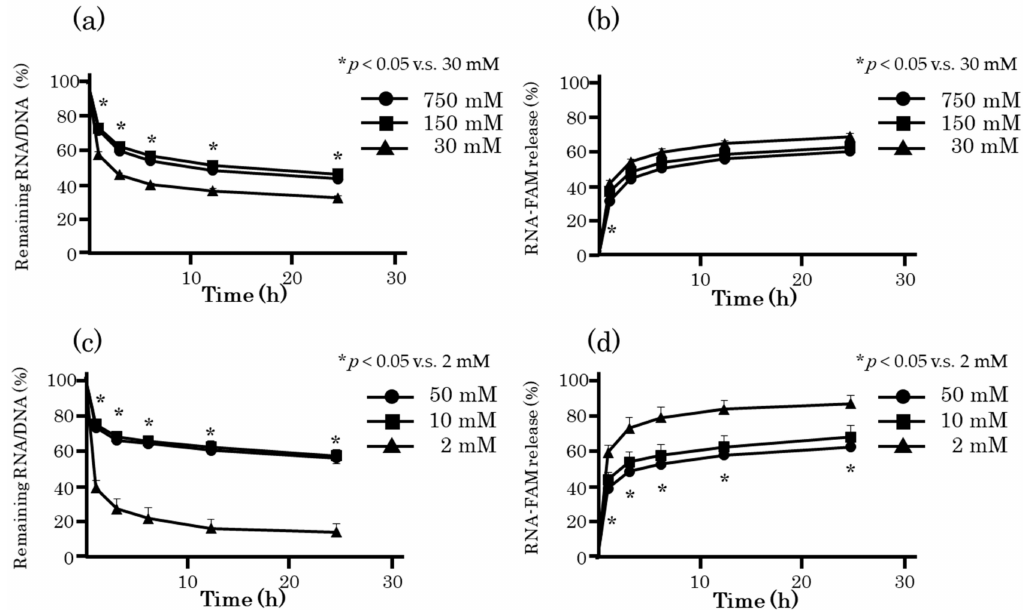
Figure 4. ORN-1 released from RDgel prepared with di ff erent metal ions. RDgel prepared with 30, 150, or 750 mM sodium ions, or with 2, 10, 50 mM magnesium ions was used. ( a ) Time course of the amount of RNA / DNA in RDgel prepared with sodium ions remaining on the Transwell chamber. The amount of RNA / DNA at 1, 3, 6, 12, and 24 h after RNA / DNA addition was calculated by subtracting the released amount from the total amount. ( b ) Time course of FAM-ORN-1 released from RDgel prepared with sodium ions. The fluorescence intensity of PBS in the lower chamber was measured at 1, 3, 6, 12, and 24 h after starting the experiment. ( c ) Time course of the amount of RNA / DNA in RDgel prepared